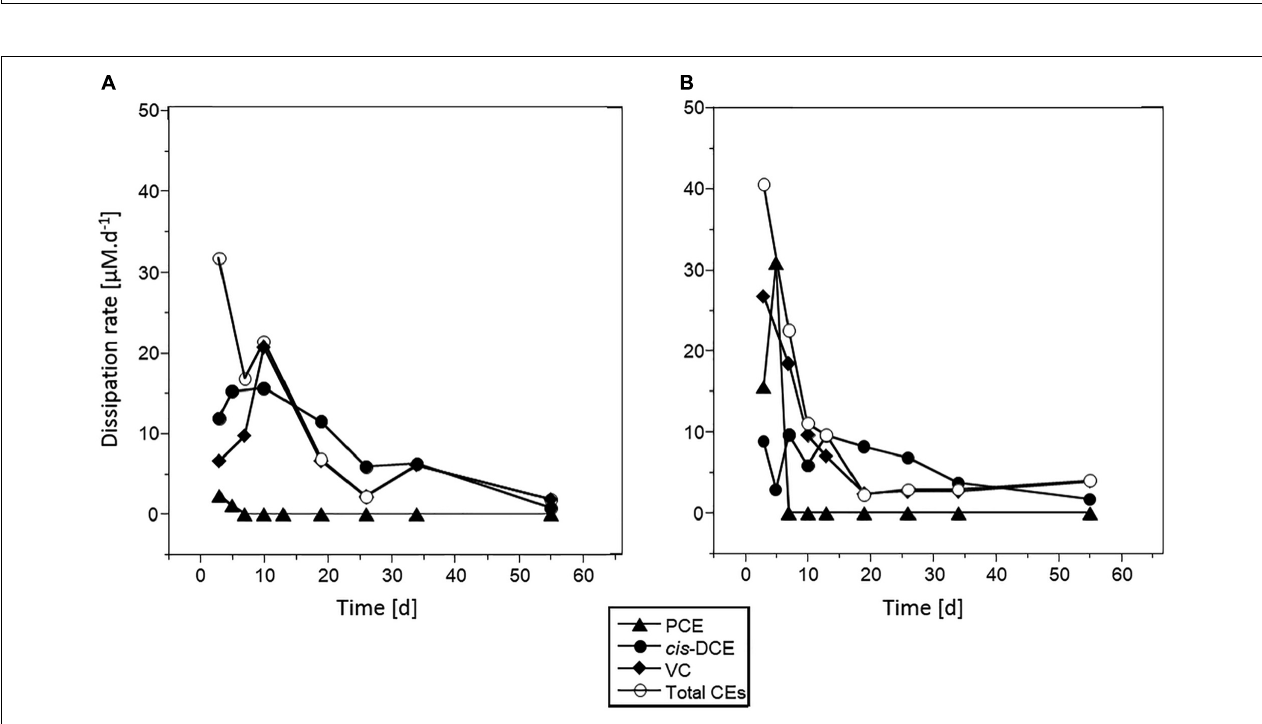
FIGURE 3 | Chlorinated ethene dissipation in microcosms spiked with PCE and acetate. Dissipation rates estimated for PCE (triangles), cis -DCE (circles), VC (diamonds), and total chlorinated ethenes (white circles) are given for microcosms spiked with 10 µ M PCE (A) or 100 µ M PCE (B) .